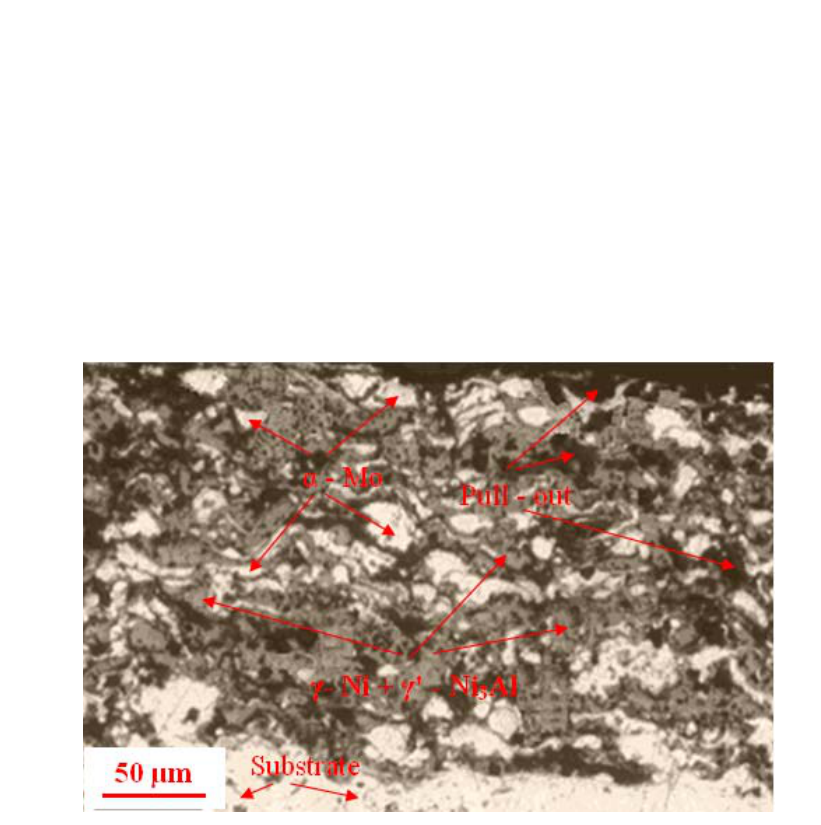
Figure 6 – (OM) Microstructure of the Ni5,5wt.%Al5 wt.%Mo coating deposited with a powder feed rate of 60 g/min Рис . 6 – (OM) Микроструктура Ni5,5 вес .%Al5 вес .%Mo покрытия ,